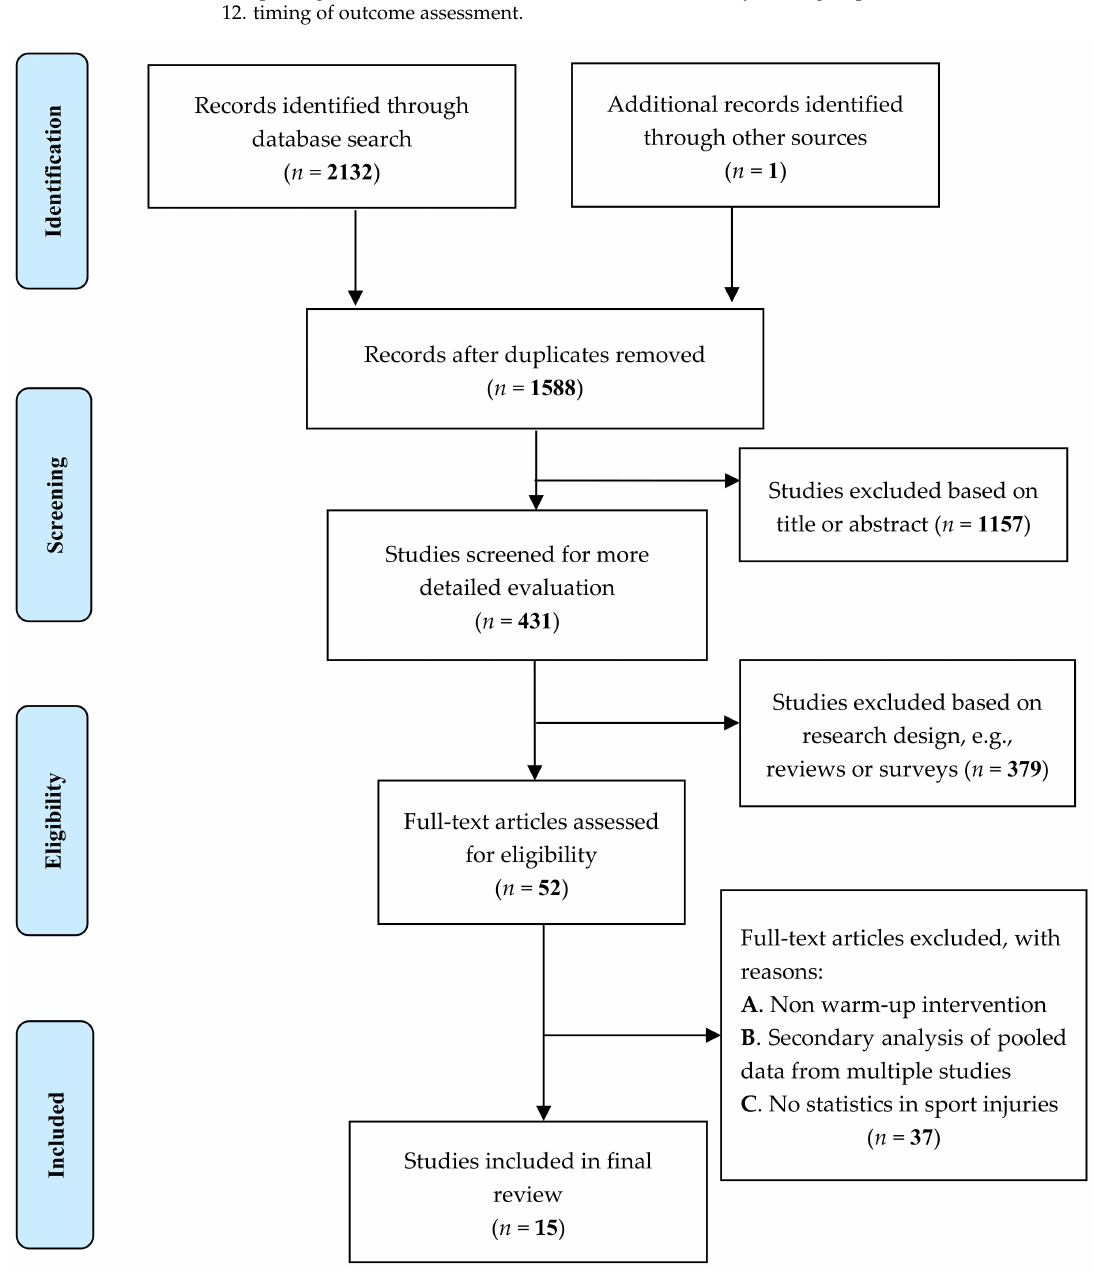
Figure 1. Flow diagram for screening and selection of studies according to PRISMA (Appendix